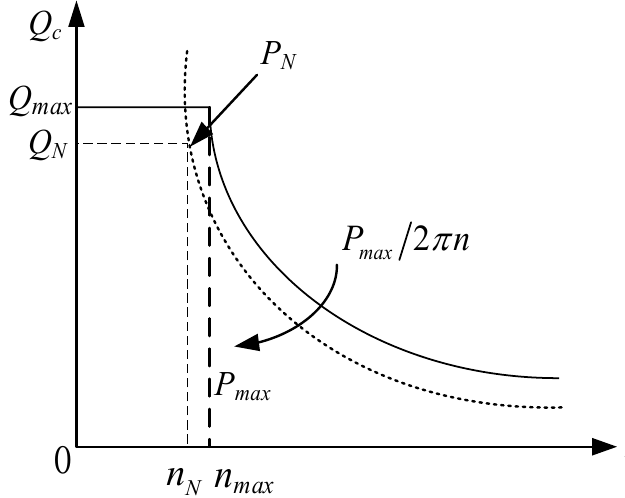
Figure 2. Torque ‐ limiting curve. Figure 2. Torque-limiting